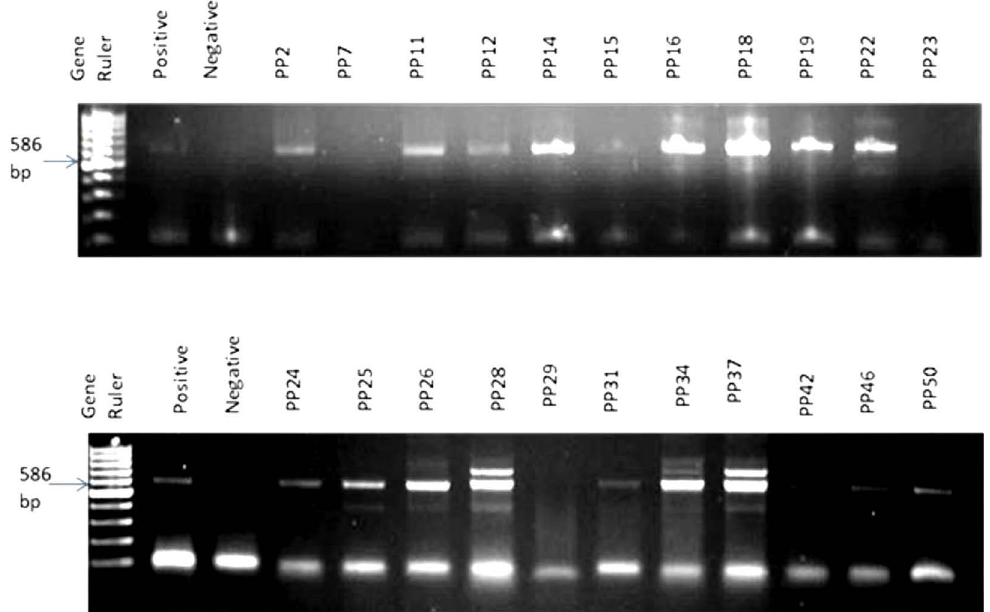
Fig. 1. A random representative gel electrophoresis of PCR confirmation of bacteria in Perna perna . Gel 1: Lanes 1: 100 bp DNA ladder, 2: positive control; 3: negative control, 4: PP2, 5:PP7, 6:PP11, 7:PP12, 8:PP14, 9:PP15,